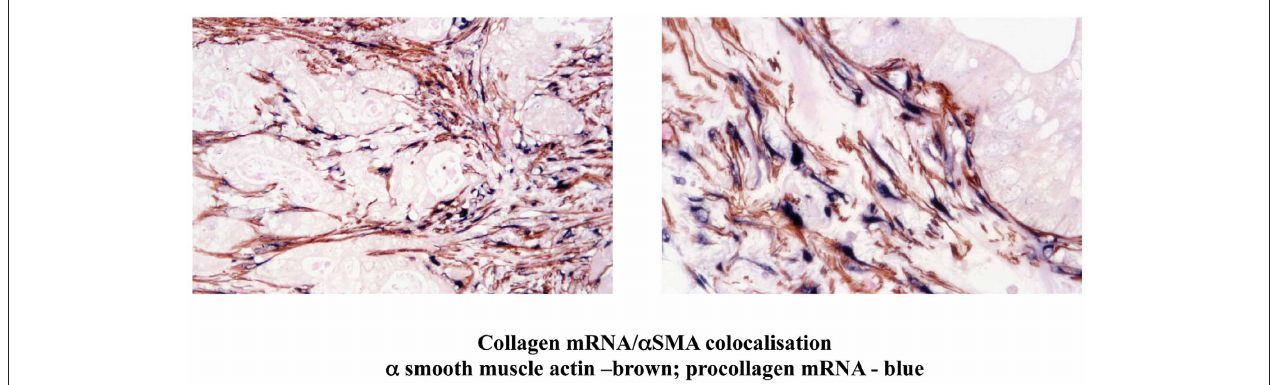
FIGURE 5 | Dual staining of a human pancreatic cancer section for α smooth muscle actin ( α SMA) and mRNA for collagen. The Figure depicts low and high power views of a pancreatic cancer section immunostained for α SMA and for collagen mRNA using in situ hybridisation. The brown staining for α SMA is co-localized with the blue staining for